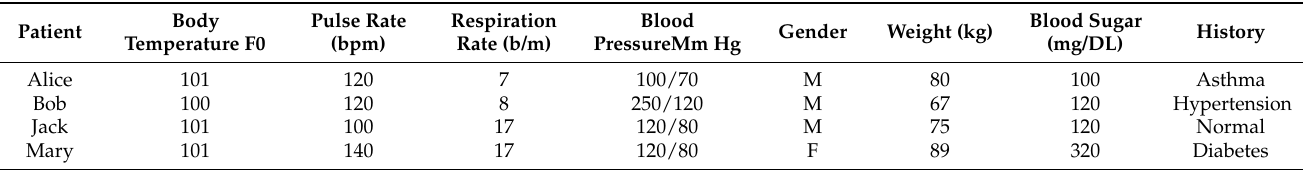
Table 3. Patients’ data used for case